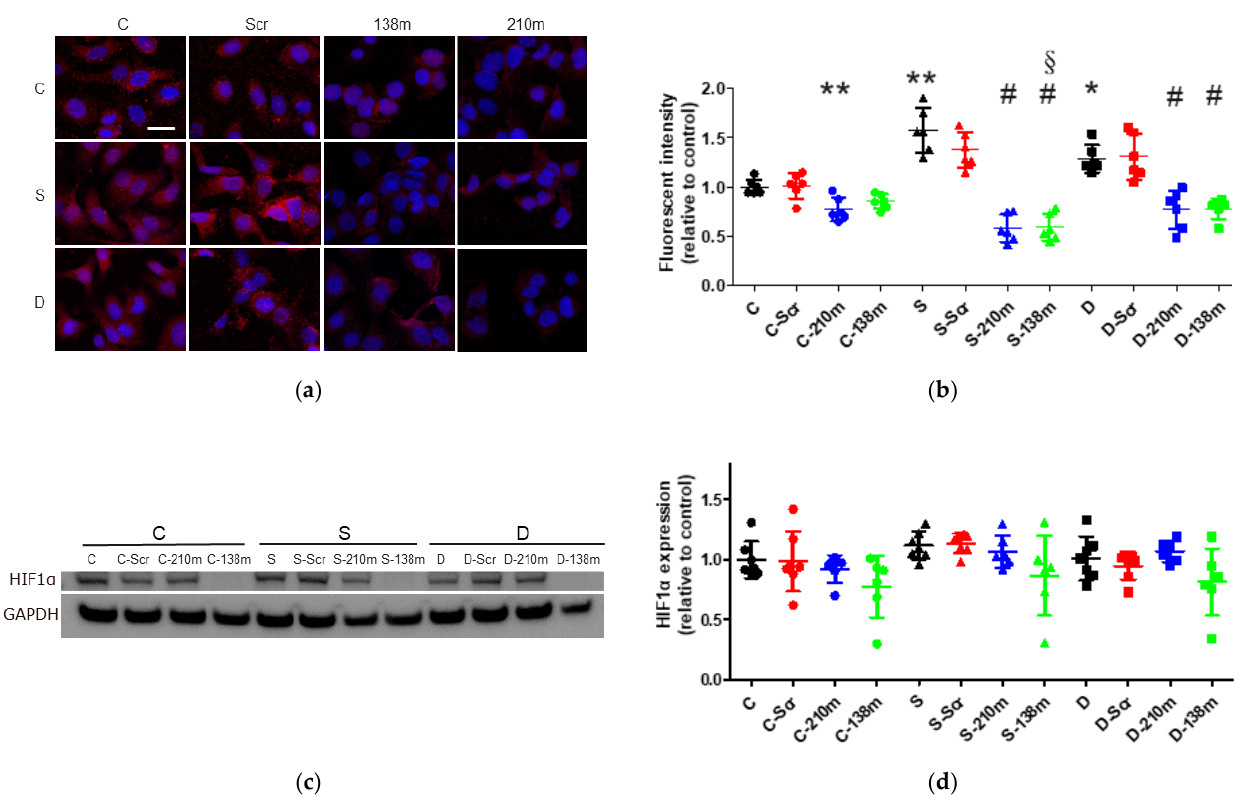
Figure 3. The HIF-1 α expression changes after inhalational anaesthesia with mimic miRNA pretreatment. ( a ) HIF-1 α immunofluorescence staining, HIF-1 α (red) in control (left), sevoflurane- (middle) and desflurane-treated (right) SKOV3 cells with mimic miRNA pretreatment, counterstained with DAPI (blue); x20 magnification, scale bar = 20 μ m. ( b ) The comparison of the HIF-1 α immunofluorescence intensity with each anaesthetic and mimic miRNA pretreatment. ( c ) The representative image of HIF-1 α Western blotting analysis with anaesthesia and mimic miRNA pretreatment. ( d ) The comparison of HIF-1 α expression in Western blotting after anaesthesia and mimic miRNA pretreatment. Data showed as plots and mean ± SD. * p < 0.05, ** p < 0.01, n = 6. One-way ANOVA with Tukey-Kramer compared to the control group, # p < 0.05; one-way ANOVA with Tukey-Kramer compared to each control group, § p < 0.05; one-way ANOVA with Tukey-Kramer compared to the control group with the same mimic miRNA pretreatment. C: control, S: sevoflurane, D: desflurane, CCK8: Cell Counting Kit-8, Scr: scrambled miRNA, 138m: miR-138 mimic and 210m: miR-210 mimic.